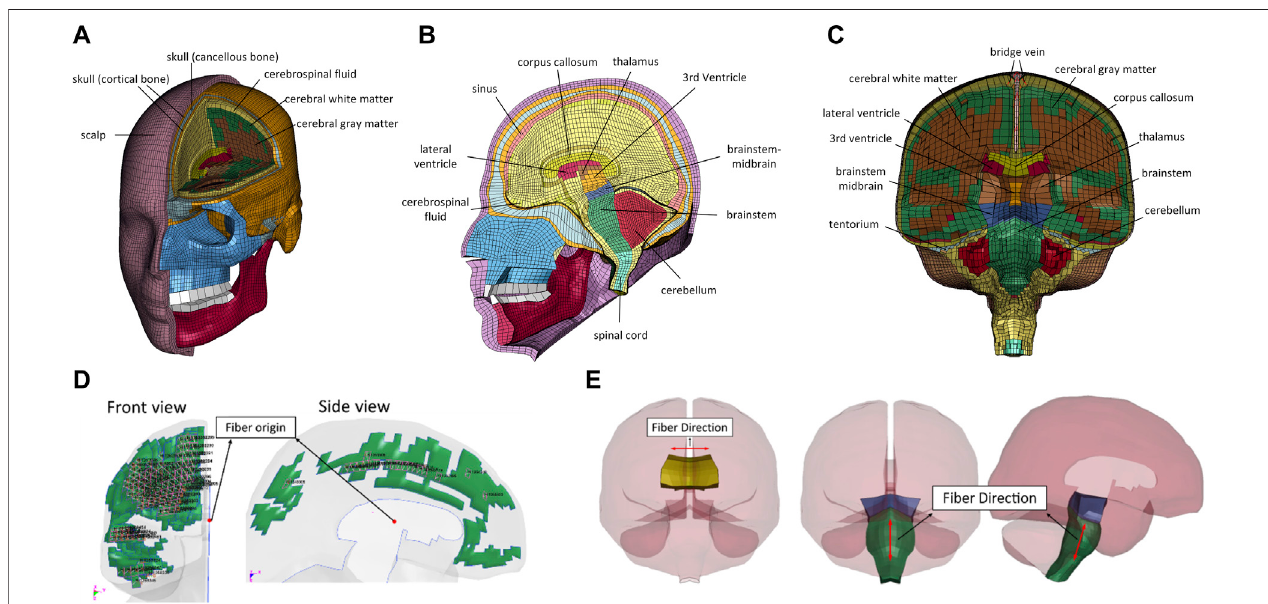
FIGURE1| IllustrationofGHBMC M50FEheadmodel: (A) frontalview; (B) sagittalview; (C) coronalviewanisotropicvisco-hyperelastic materialmodel; (D) frontal and side views of the fi ber direction de fi ned in the subcortical white matter; (E) fi ber directions de fi ned in corpus callosum and